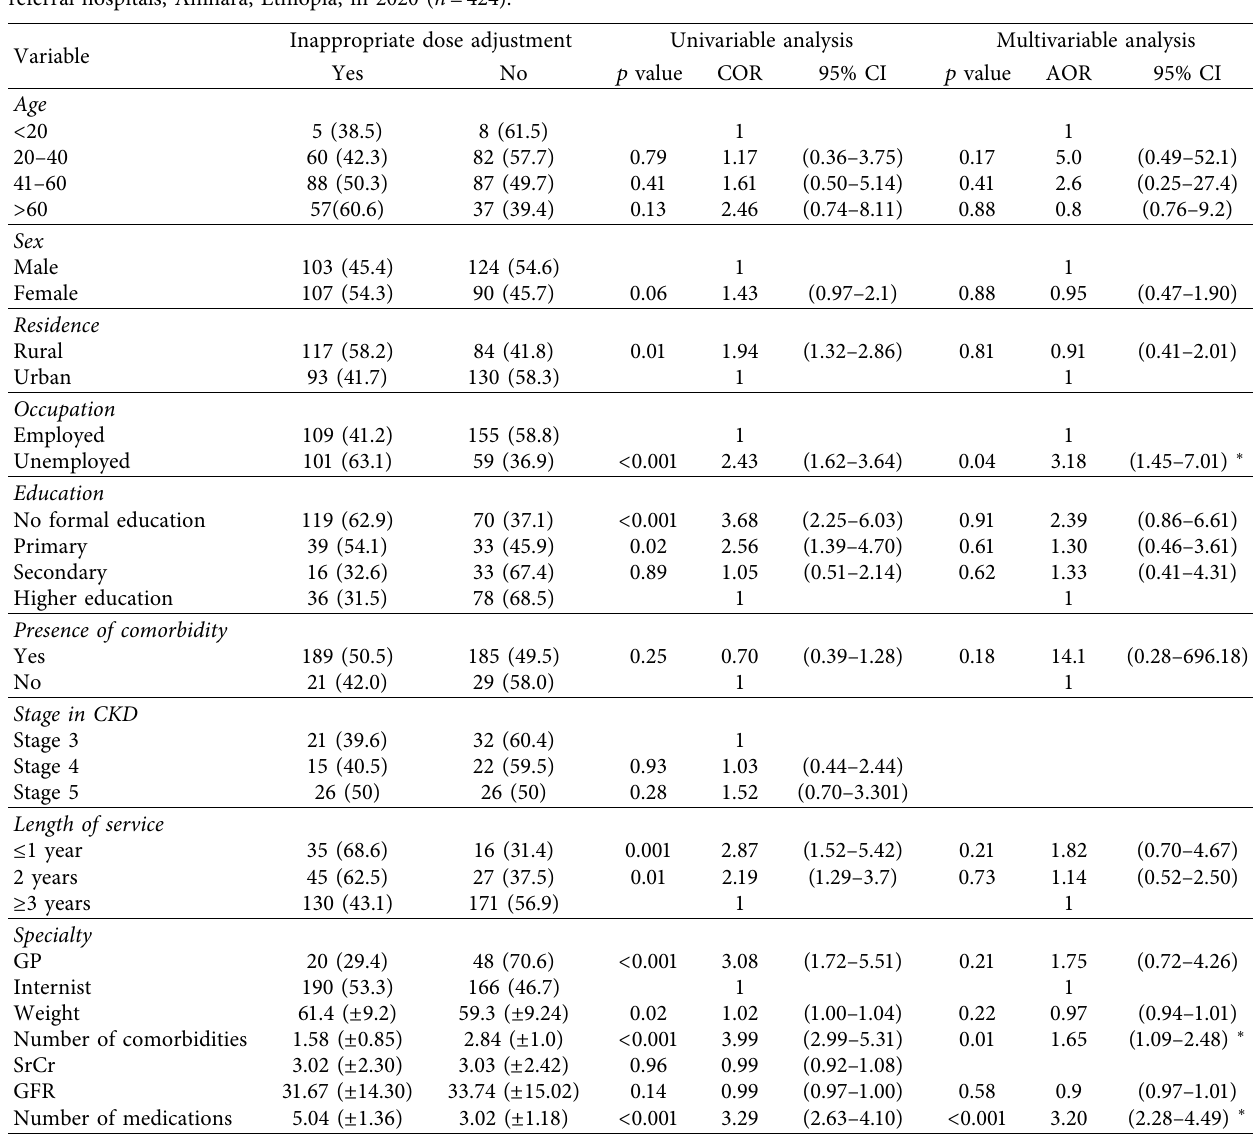
Table 6: Factors associated with dose adjustment practice in patients with renal impairment admitted to medical wards at Amhara region referral hospitals, Amhara, Ethiopia, in 2020 ( n �